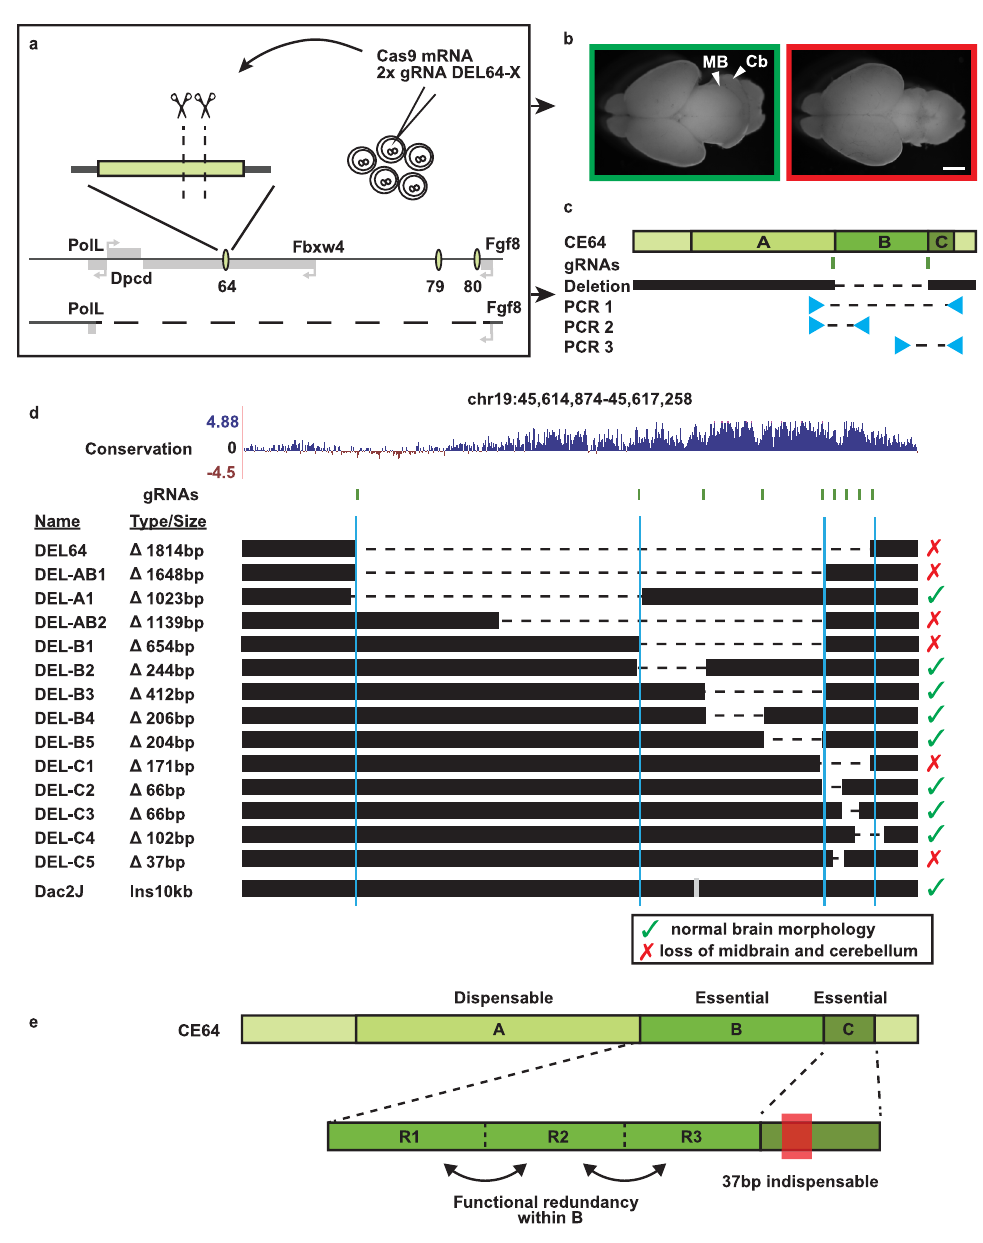
Fig. 4 Two distinct subunits with internal redundancy are required for CE64 function. a Schematic representation of the CRISPR screen setup. Oocytes were fertilized with males carrying one DEL(P-F8) allele (bottom) and 2 gRNAs were simultaneously injected with Cas9 mRNA. b Brain morphology of F0 embryos was examined at e18.5 and all embryos were genotyped according to strategy in c to identify breakpoints and possible mosaicism. d Representation of the panel of deletions generated. The in vivo CRISPR/ Cas9 screen de fi ned two indispensable subunits of CE64 (DEL-B and DEL-C). Removing overlapping bits within these units (DEL-B2 through DEL-B5, DEL-C2 through DEL-C4) does not provoke any phenotype. The smallest deletion causing lack of MHB derived structures is merely 37 bp (DEL-C5). Red cross indicates loss of MHB derived tissues and green tick indicates normal brain morphology. Vertical grey dash indicates location of 10 kb insertion in Dac2J mice. e Schematic representation of the functional units of CE64. Both 64-B and 64-C are indispensable for CE64 function, while 64-A is not required. Functional redundancy is encoded within these subunits although a deletion of only 37 bp is enough to abrogate the function of 64-C. Scale bar in b is 1